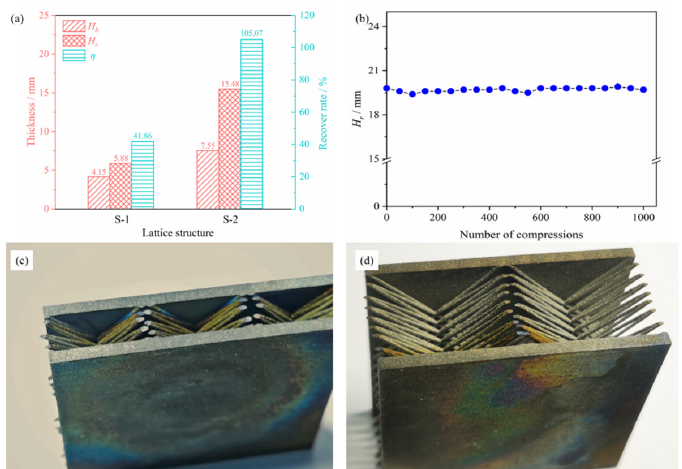
Figure 6. Resilient and cycle resilient performance of the BWR lattices: ( a ) Resilient performance; ( b ) Cycle resilient performance of S ‐ 2; ( c ) Image of the recovered S ‐ 1; ( d ) Image of the recovered S ‐ 2.